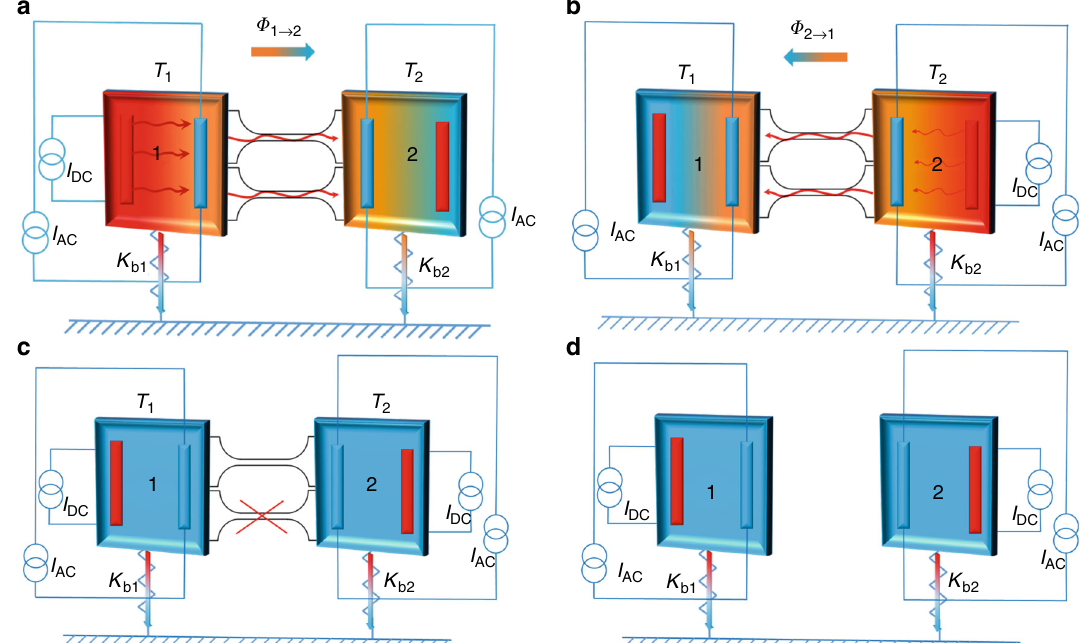
Fig. 2 Sample design and experimental protocols. The membranes are schematized by a colored square containing a heater in red and a thermometer in blue. Several experimental protocols have been used, a where the temperature gradient is established through a DC current applied to the heater on the right membrane creating a continuous heat fl ow to the left membrane through the 1D phonon waveguide. The two temperatures T 1 and T 2 are measured with the two thermometers and b the DC current is supplied to the heater on the left membrane, the heat fl ow is then reversed as compared to the case a . The two fi rst protocols ( a , b ) have been established to verify the symmetry of heat transport in the nanowires. In protocol c , one of the nanowires has been cut by FIB, then the steps a , b are repeated to check the additivity of the heat fl ow and potentially to probe the number of conducting channels in